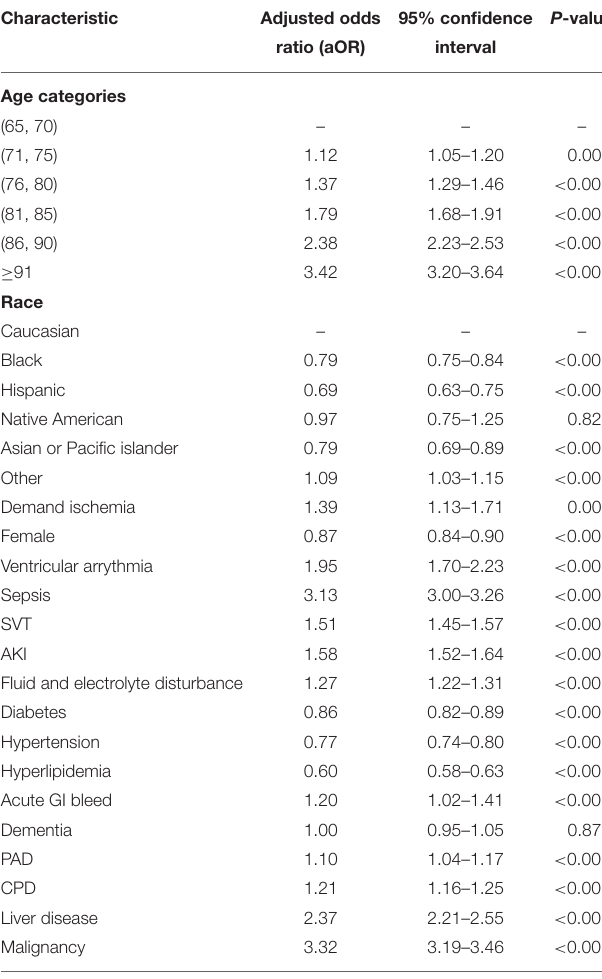
TABLE 2 | Association between demand ischemia and in hospital mortality adjusting for demographics and clinically relevant characteristics. Characteristics